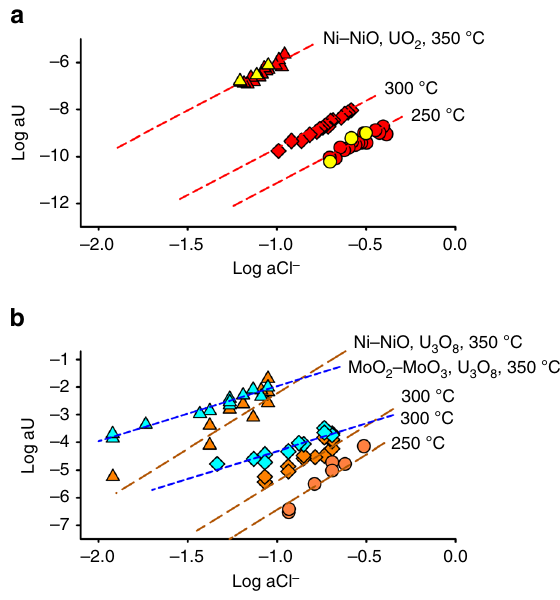
Fig. 1 The activity of uranium determined experimentally to be in equilibrium with uranium oxide solids. a Uranium activity as a function of chloride activity for experiments conducted using UO 2 cryst under reducing conditions. Red circles, diamonds, and triangles indicate results obtained at 250, 300, and 350 °C, respectively. The slope of all trend lines is 4. The yellow circle and triangle symbols indicate use of the Co – CoO buffer at 300 and 350 °C, respectively. The results of these experiments are indistinguishable from those utilizing the Ni – NiO buffer. All data are normalized to a pH of 2.5 using the stoichiometry of Reactions (1), (2), and (3). The trend lines represent the best fi ts to the data, and were calculated using the equilibrium constants for the speciation reaction (Table 1). b Uranium activity determined from solubility experiments employing U 3 O 8 cryst plotted for speci fi ed temperature (circles — 250 °C, diamonds — 300 °C, triangles — 350 °C) and oxygen fugacity (oxidizing — blue; reducing — brown) as a function of chloride activity. The slope of the fi t under oxidizing conditions is 2, and under reducing conditions it is 4. Trend lines for data representing oxidizing conditions were calculated using equilibrium constants of 39.6 and 50.9 at 300 and 350 °C, respectively. They were fi tted independently of those described in ref. 21 .